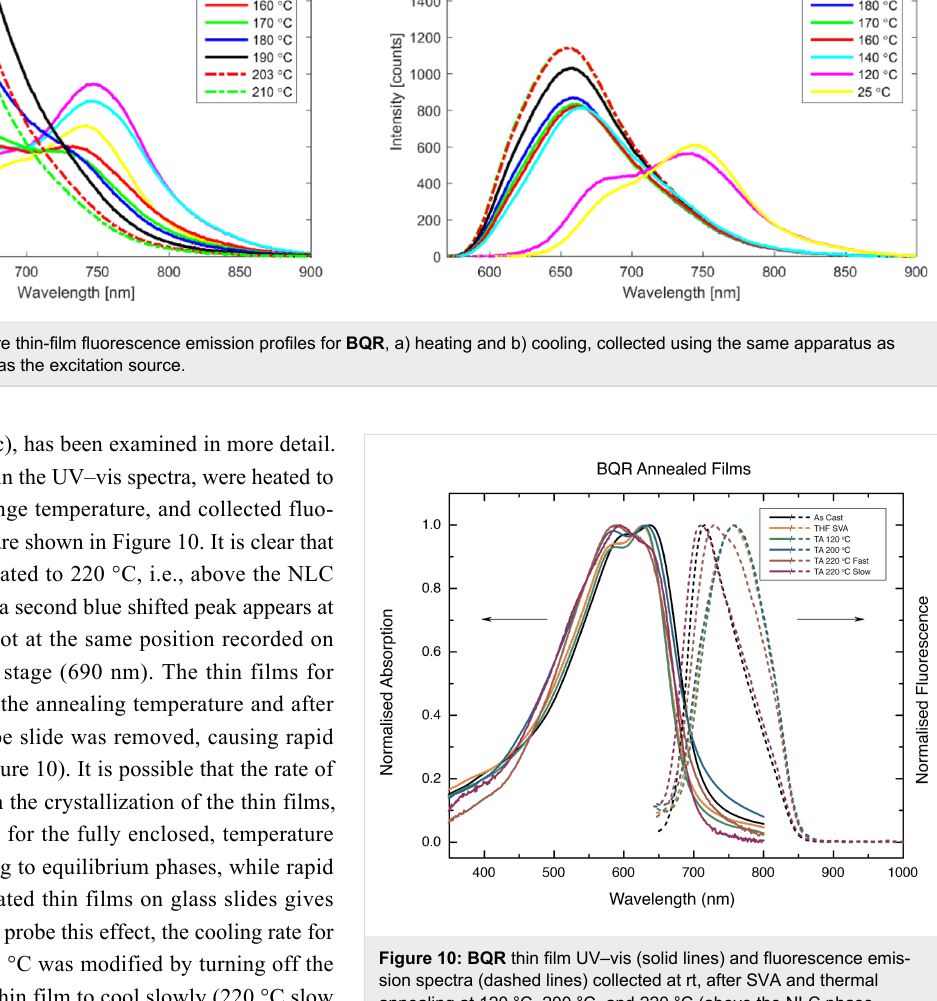
Figure 10: BQR thin film UV–vis (solid lines) and fluorescence emis- sion spectra (dashed lines) collected at rt, after SVA and thermal annealing at 120 °C, 200 °C, and 220 °C (above the NLC phase change temperature). Films heated to 220 °C were either removed from the hotplate and cooled (fast) or left on the hotplate to cool